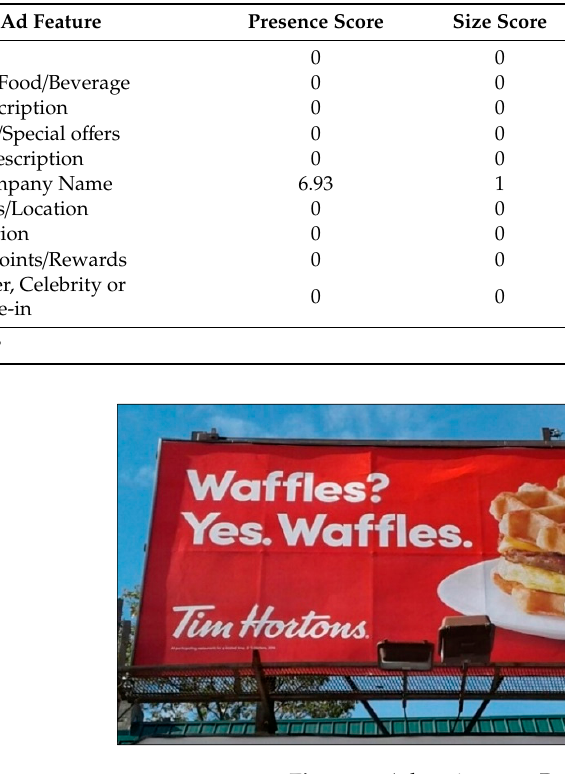
Table 5. Coding example using the teen-developed tool: Advertisement A.